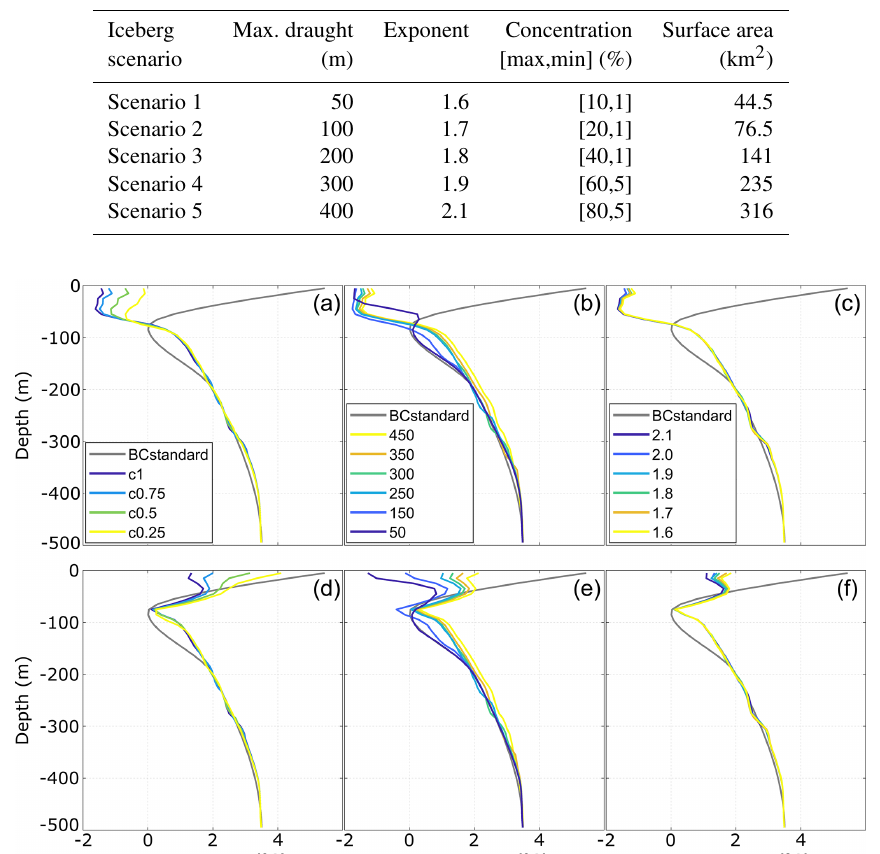
Figure 3. Glacier-adjacent water temperature vs. iceberg geometry and distribution. Effect of iceberg concentration (a, d) , maximum iceberg draught (b, e) and exponent describing the size-frequency distribution (c, f) . Panels (a) – (c) are for simulations without subglacial discharge, whilst panels (d) – (f) are for simulations with 500m 3 s − 1 subglacial